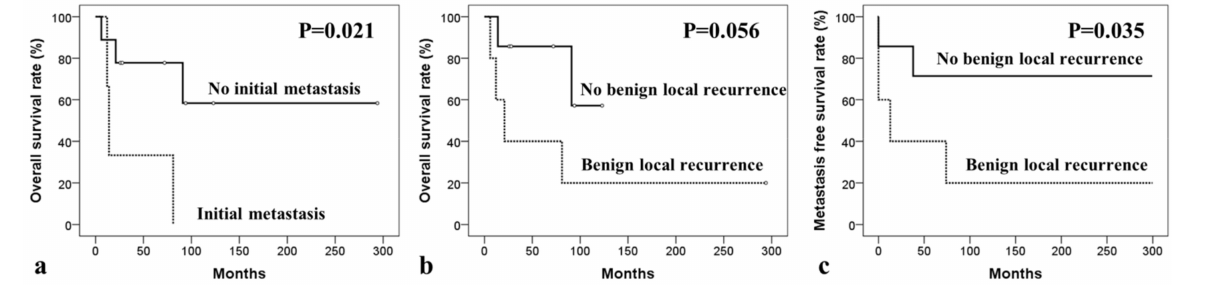
Figure 1. Kaplan–Meier survival curves of univariate analyses for secondary malignancy in giant cell tumor. Kaplan–Meier curves for overall survival according to ( a ) initial metastasis and ( b ) benign recurrence of giant cell tumor of bone, and for ( c ) metastasis-free survival depending on benign local